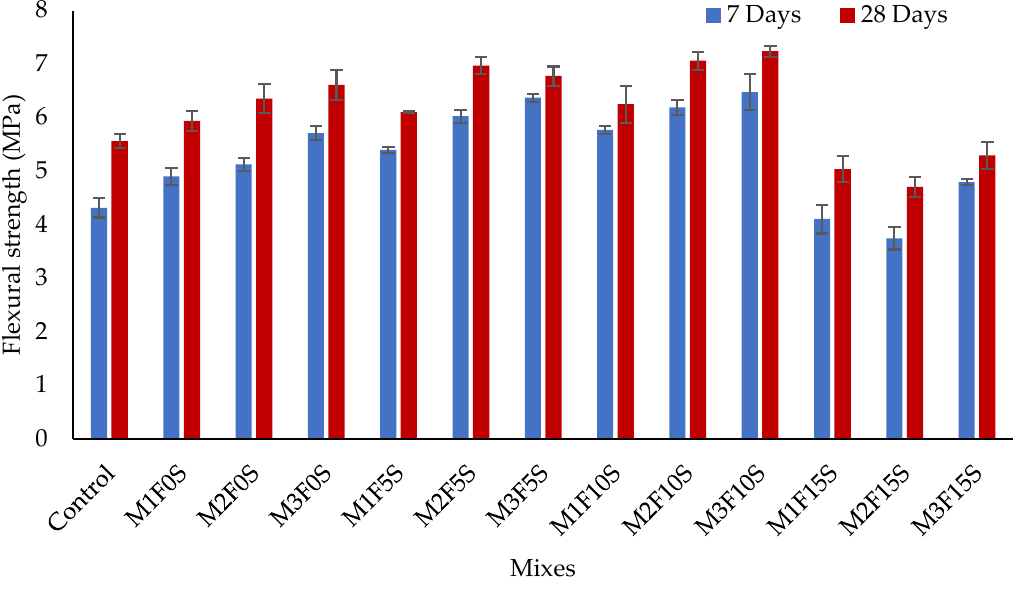
Figure 9. Flexural strength results.